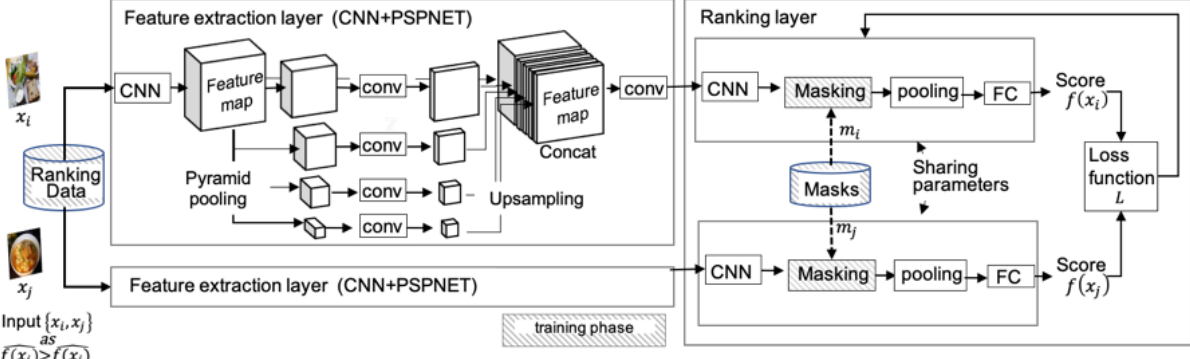
Figure 3. Proposed system for training ranking data of meals. The feature extraction layer consists of the convolutional neural network (CNN) and the same network as that of the pyramid scene parsing network (PSPNet) [27], which outputs pixel-wise feature maps. The ranking layer module is for estimating the scores. FC: fully convolutional